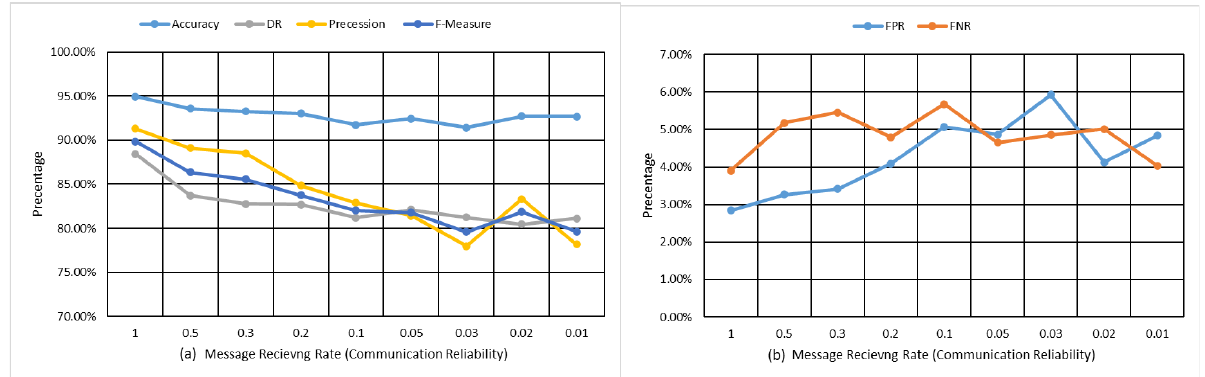
Figure 5. Performance evaluation of the proposed FCA-MDS model in terms of ( a ) accuracy, DR, precession, and F-measure and ( b ) FPR and FNR.